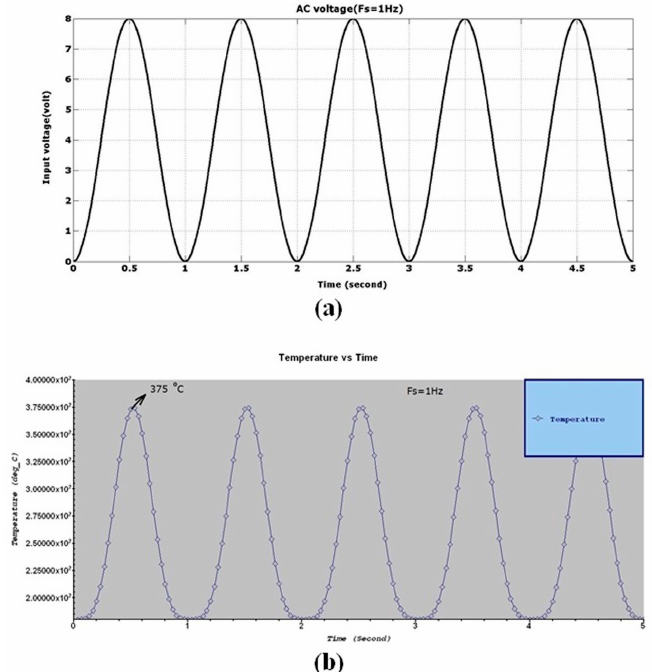
Figure 6. Dynamic behavior of the structure shown in Figure 5c: ( a ) Input voltage applied with a frequency of f = 1 Hz. ( b ) Temperature variation in the center shaft (max Temperature = 375